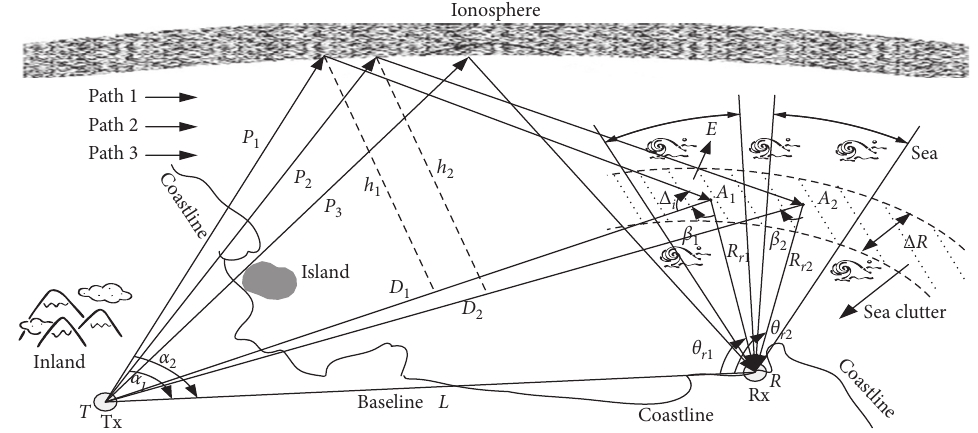
Figure 1: Geometry and layout diagram of HF sky-surface wave